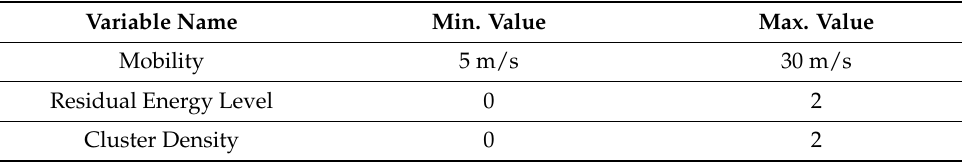
Table 2. Minimum and maximum values for Fuzzy Input Variables.